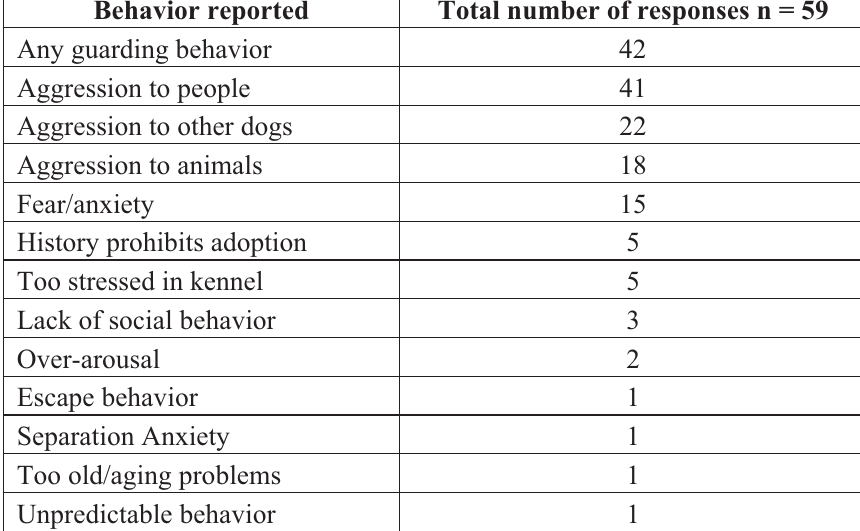
Table 7. Responses to the open-ended question: “Name the top three behavioral reasons dogs are identified as unadoptable at your